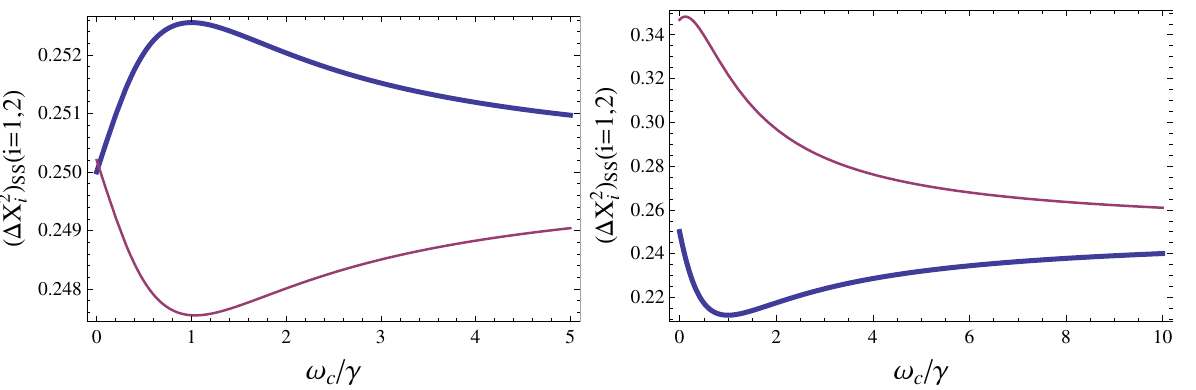
(thick line) and ∆ X 2 1